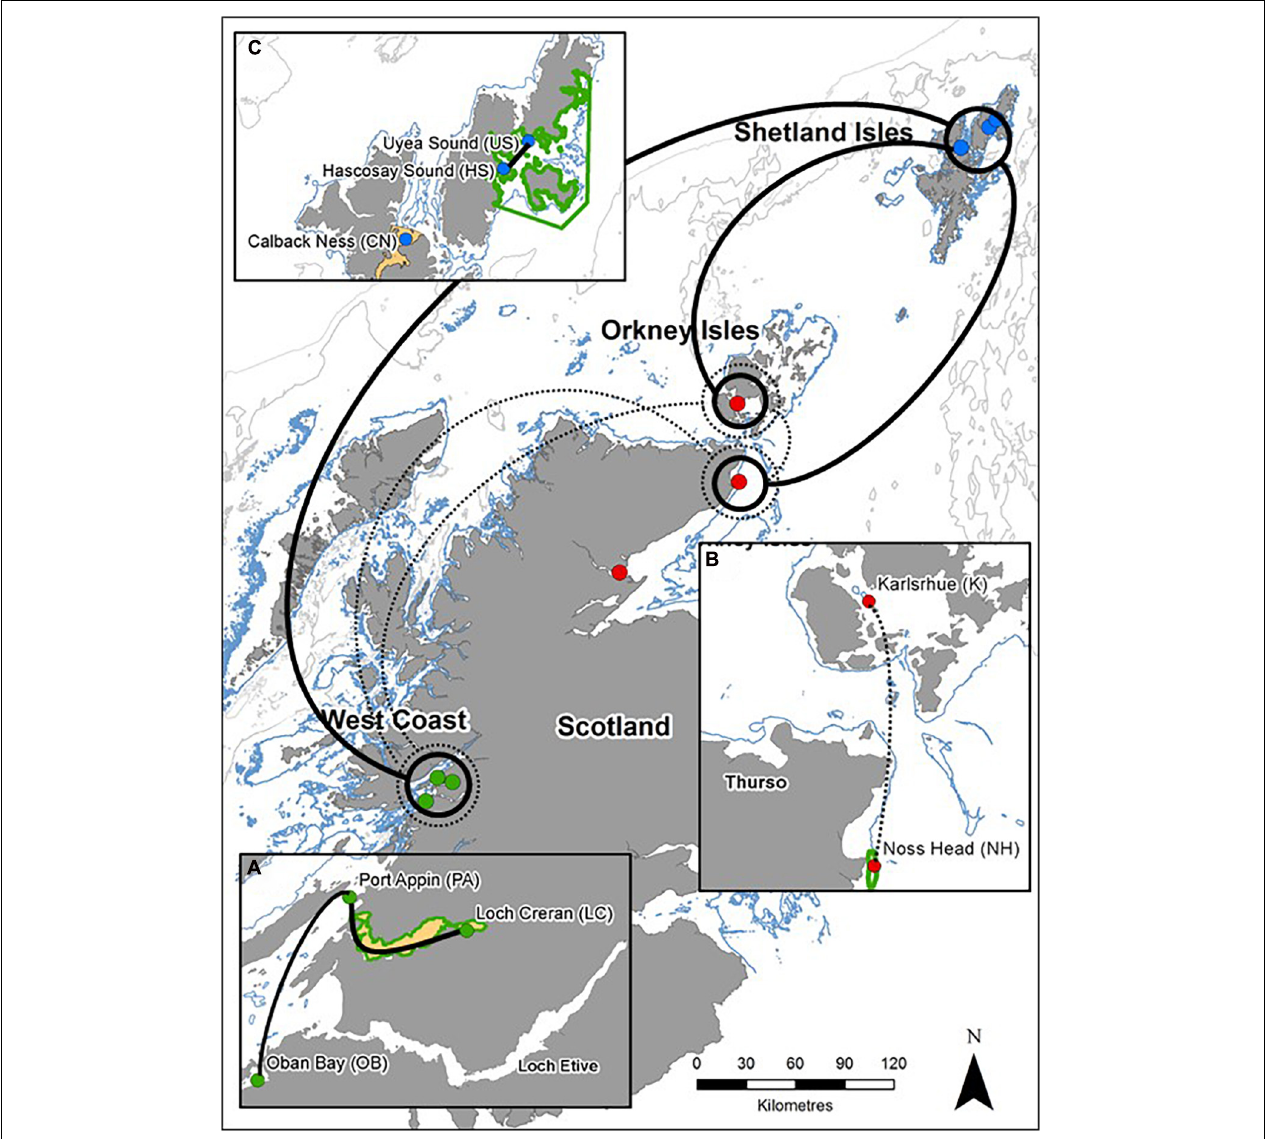
FIGURE 2 | General patterns of genetic connectivity of M. modiolus reef populations of Scotland. Solid lines indicate high genetic connectivity (low differentiation) and dashed lines indicate moderate genetic connectivity (moderate differentiation). Circles contain any/all population(s) that is/are connected to adjoining population(s). Smaller inset maps indicate intra-regional genetic connectivity: (A) West Coast, (B) North-east and Orkney Islands, and (C) Shetland Isles. Coastline Crown © and database right (2021). Ordnance Survey License number